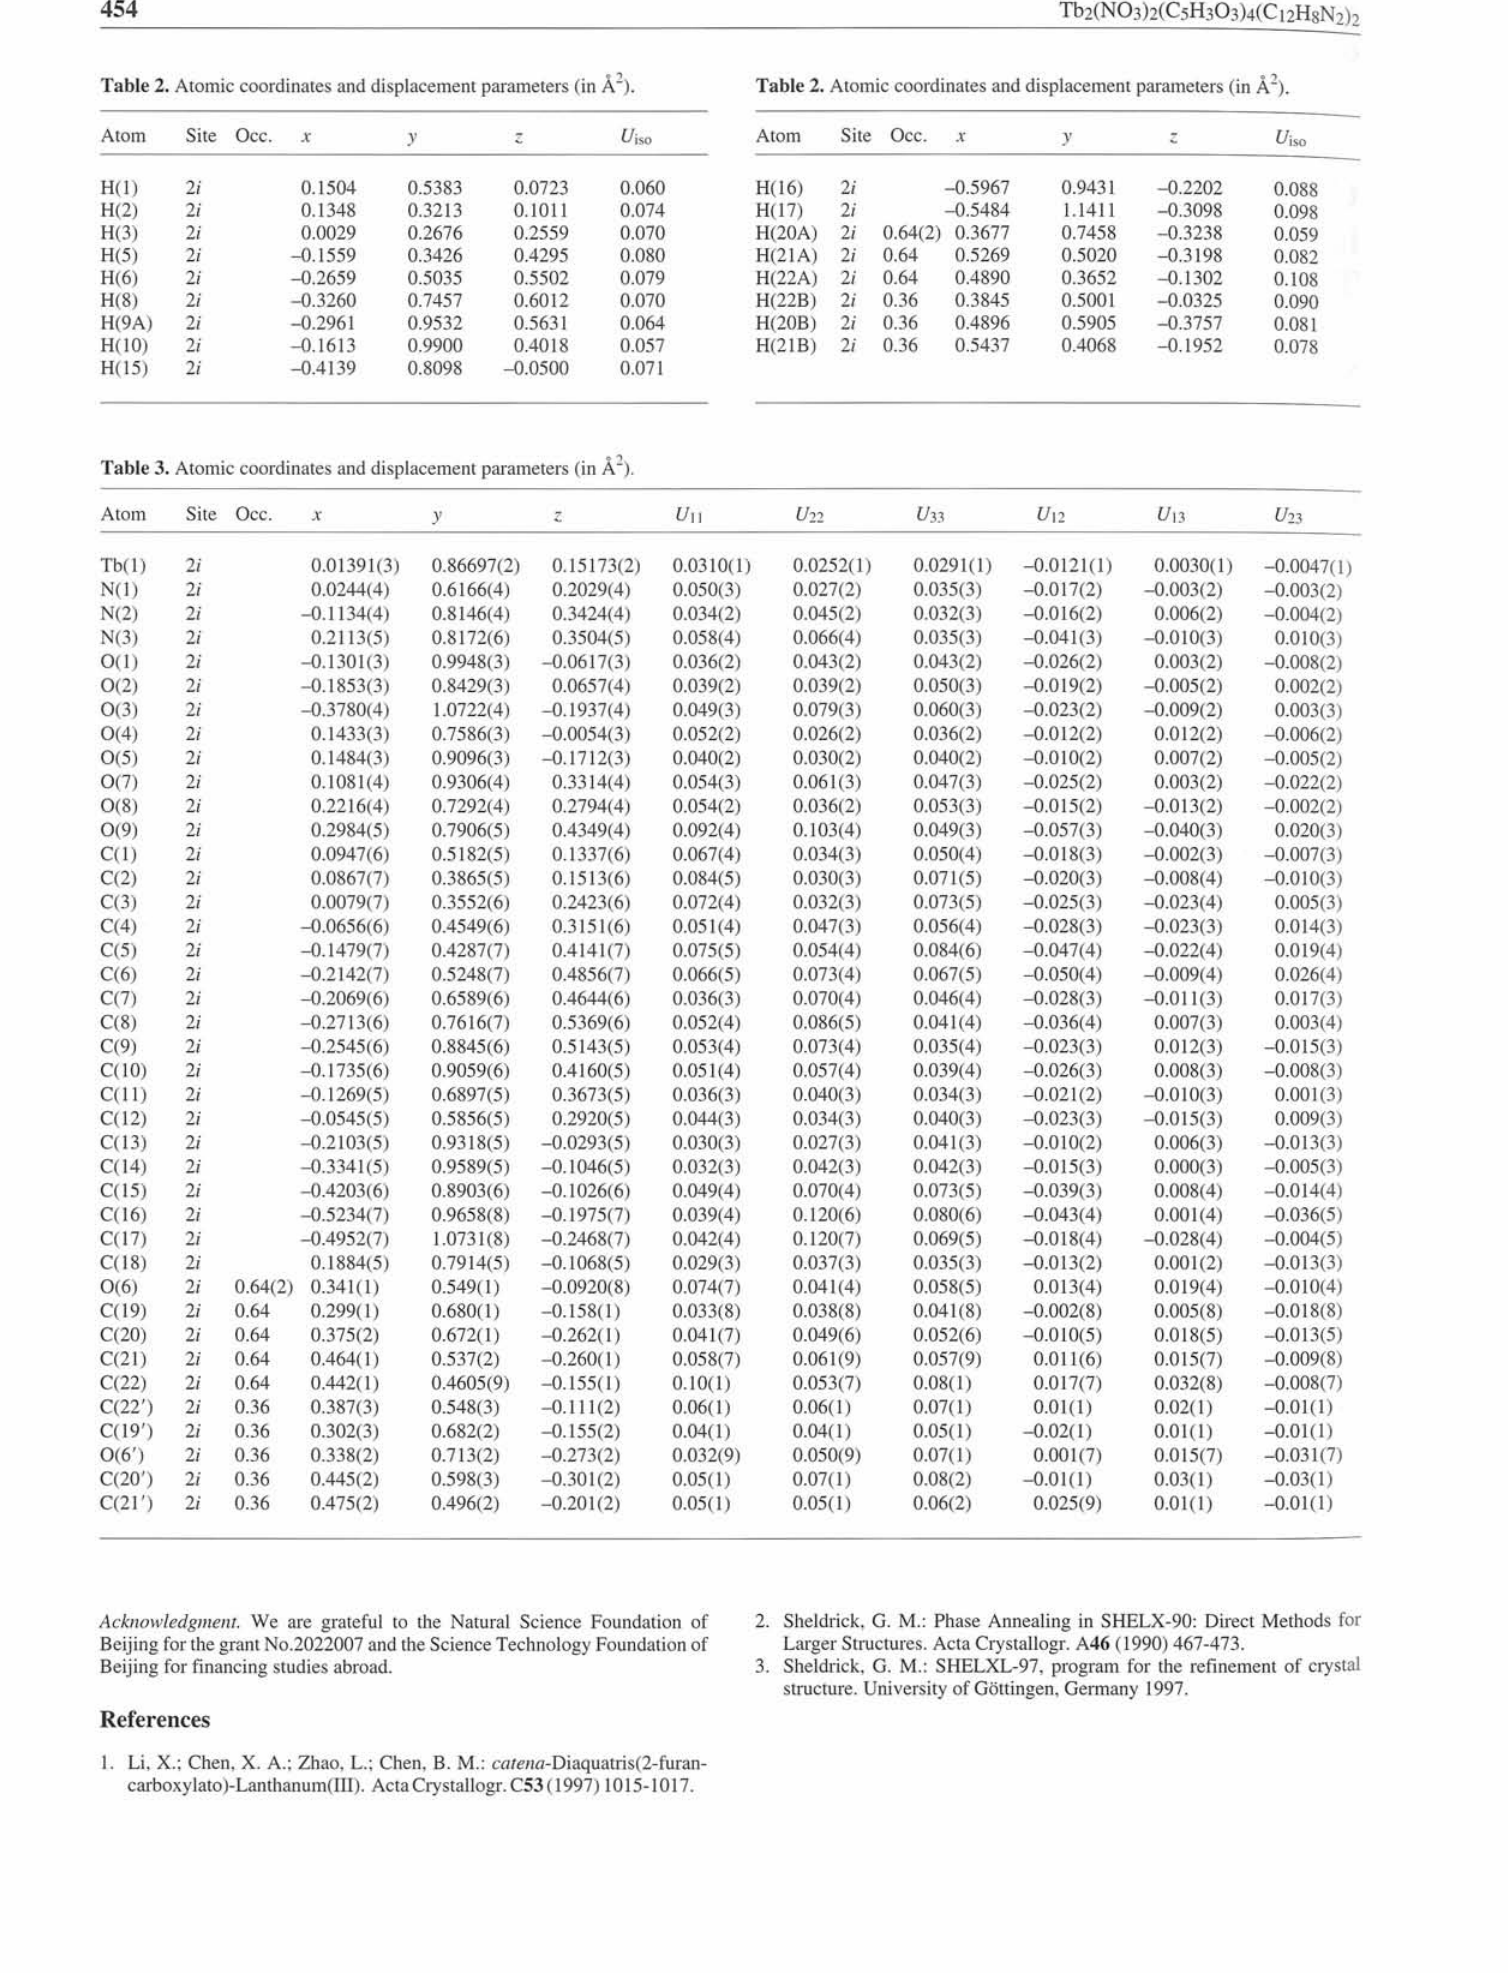
Table 2. Atomic coordinates and displacement parameters (in À 2 ).